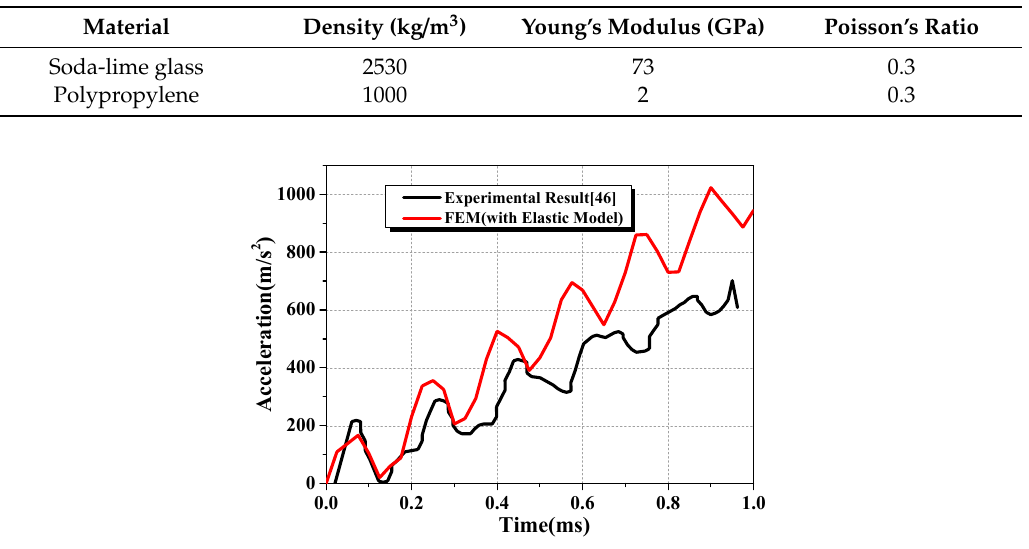
Table 2. Constants of the linear elastic model for glass and polypropylene